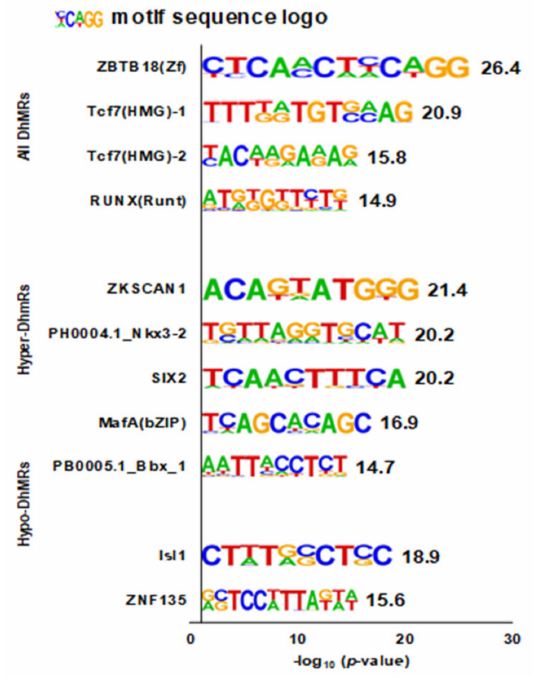
Figure 4. De novo motif identification from genes mapped to differentially hydroxymethylated regions (DhMRs) with HOMER. Abbreviations: DhMRs = differentially hydroxymethylated regions; hyper-DhMRs = differentially hyper-hydroxymethylated regions (case vs. control twins); hypo- DhMRs = differentially hypo-hydroxymethylated regions (case vs. control twins). The value next to the motif sequence logo is the negative log 10 ( p